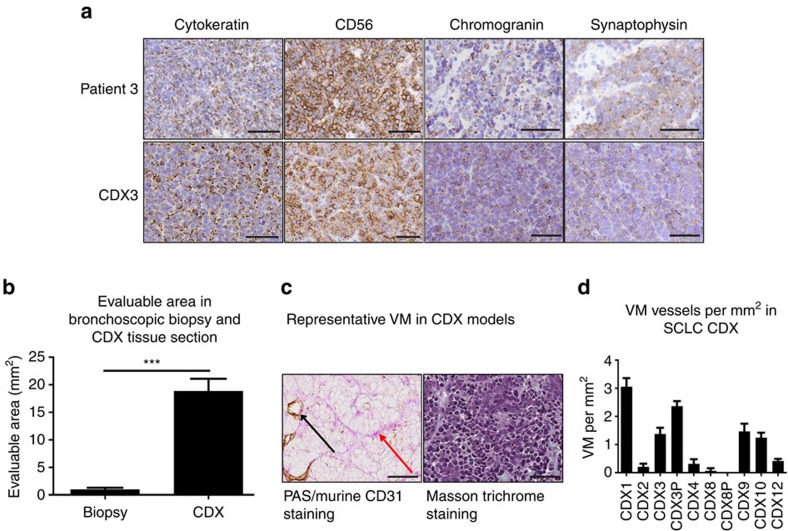
Vasculogenic mimicry in SCLC CDX tumours.(a). IHC of CK and SCLC neuroendocrine markers CD56, synaptophysin and chromogranin of a matched patient biopsy and CDX tumour. Scale bar, 50 μm. (b) Mean evaluable tumour area (mm2) in sections from n=24 patient bronchoscopic biopsies and n=10 CDX tumours (***P<0.0001, two-tailed t-test. (c) Left panel depicts PAS+VE/CD31+VE endothelial vessels (black arrow) and PAS+VE/CD31−VE VM vessels (red arrow) in a representative SCLC CDX tumour. Right panel depicts Masson trichrome staining of the same region demonstrating lack of mouse stromal contamination. Scale bar, 50 μm. (d) VM vessels per mm2 of tissue in CDX tumours derived from CTCs enriched from SCLC patients (P denotes a CDX tumour derived from a progression blood sample matched to a baseline patient sample, for example, CDX3 and CDX3P are both derived from patient 3 at presentation and progression, respectively). Error bars show s.e.m.